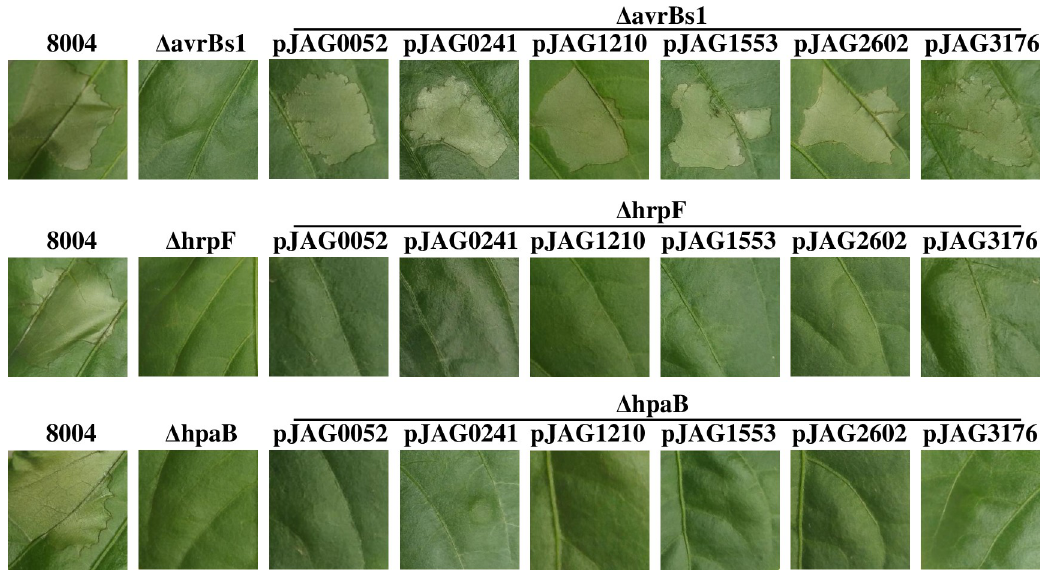
Fig 2. The translocation of T3Es is dependent on HpaB in Xcc . The mutants Δ avrBs1, Δ hpaB, and Δ hrpF carrying plasmids that respectively encode N-terminal signals of XC0052, XC0241, XC1210, XC1553, XC2602, and XC3176, in-frame fused with AvrBs1 59-445 − 3 × FLAG were infiltrated into the expanded leaves of pepper plant ( Capsicum annuum cv. ECW-10R) at an OD 600 of 0.1. The phenotypes were photographed at 24 h post-inoculation. The wild type strain 8004 was used here as the positive control and the deletion mutants Δ avrBs1 and Δ hrpF as the negative